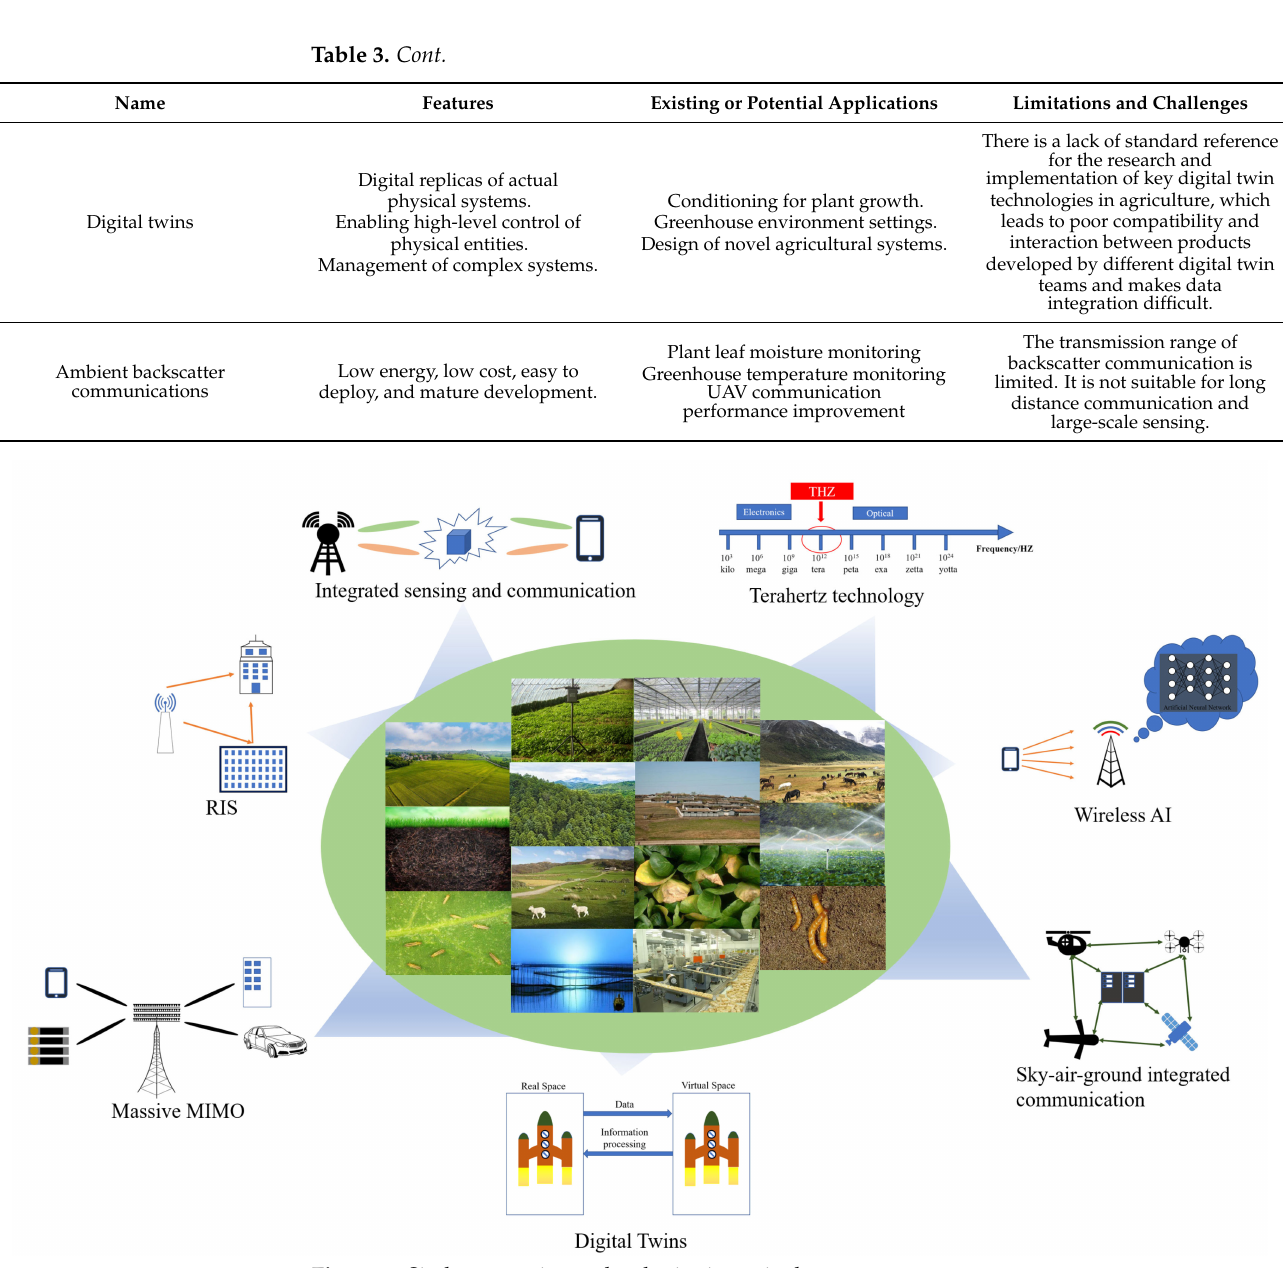
Figure 1. Sixth-generation technologies in